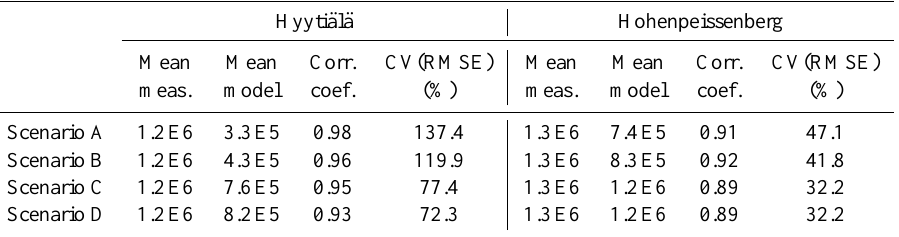
Table 2. Statistical analysis between measured and modelled sulfuric acid concentrations for Hyyti¨al¨a and Hohenpeissenberg (RMSE – root mean square error).